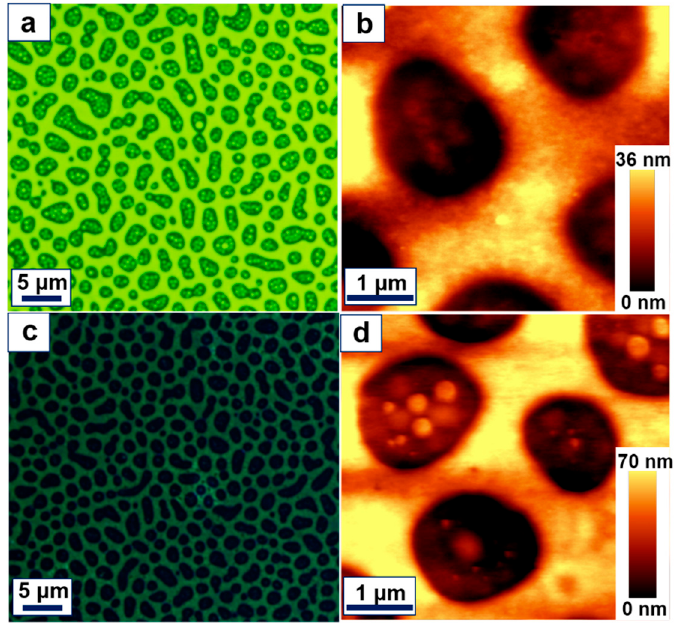
Figure 2. Optical microscopic ( left panel) and atomic force microscopic (AFM, right panel) images of the template before ( a , b ) and after ( c , d ) the laser-induced selective cross-linking process.